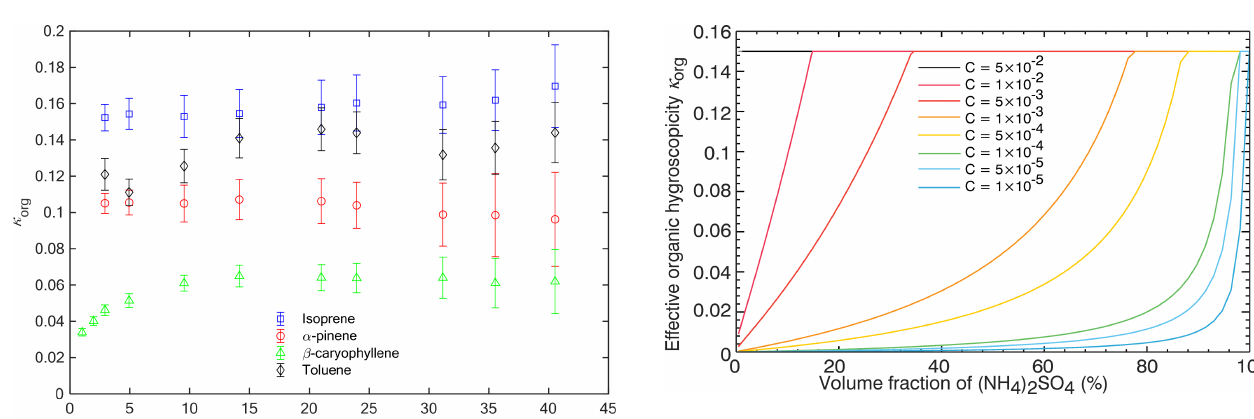
Figure 2. Simulated effective organic hygroscopicity for particles grown from 50nm dry ammonium sulfate seeds by condensation of secondary organic species with κ org,intr = 0.15. The effective or- ganic hygroscopicity is shown as a function of dry sulfate volume fraction for organic solubility C ranging from 1 × 10 − 5 to 5 × 10 − 2